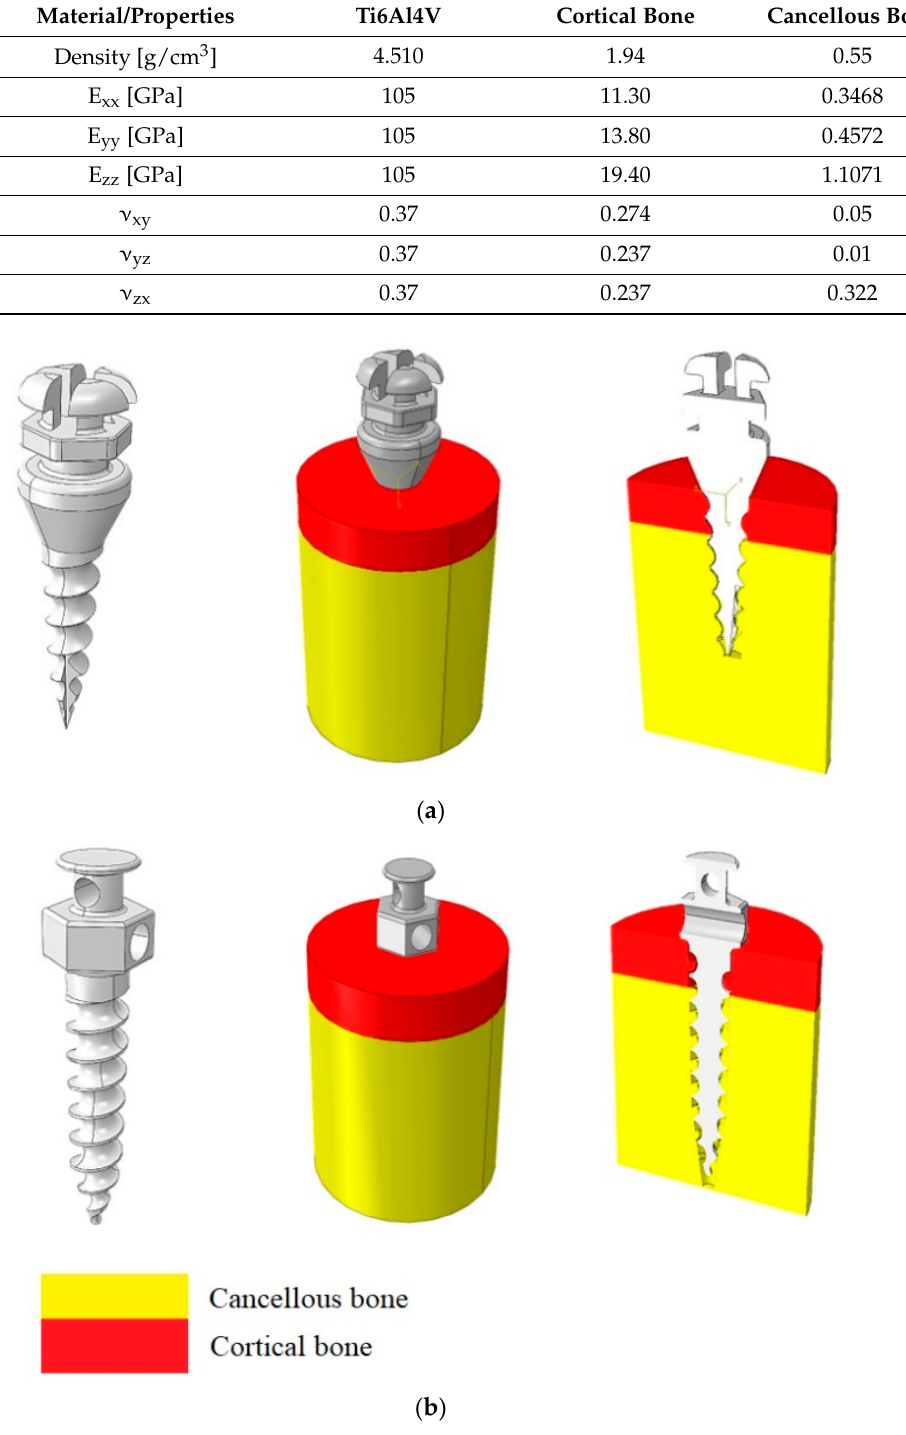
Figure 6. 3D-designed implant–bone system ( a ): Tomas ® -pin and ( b ): Perfect